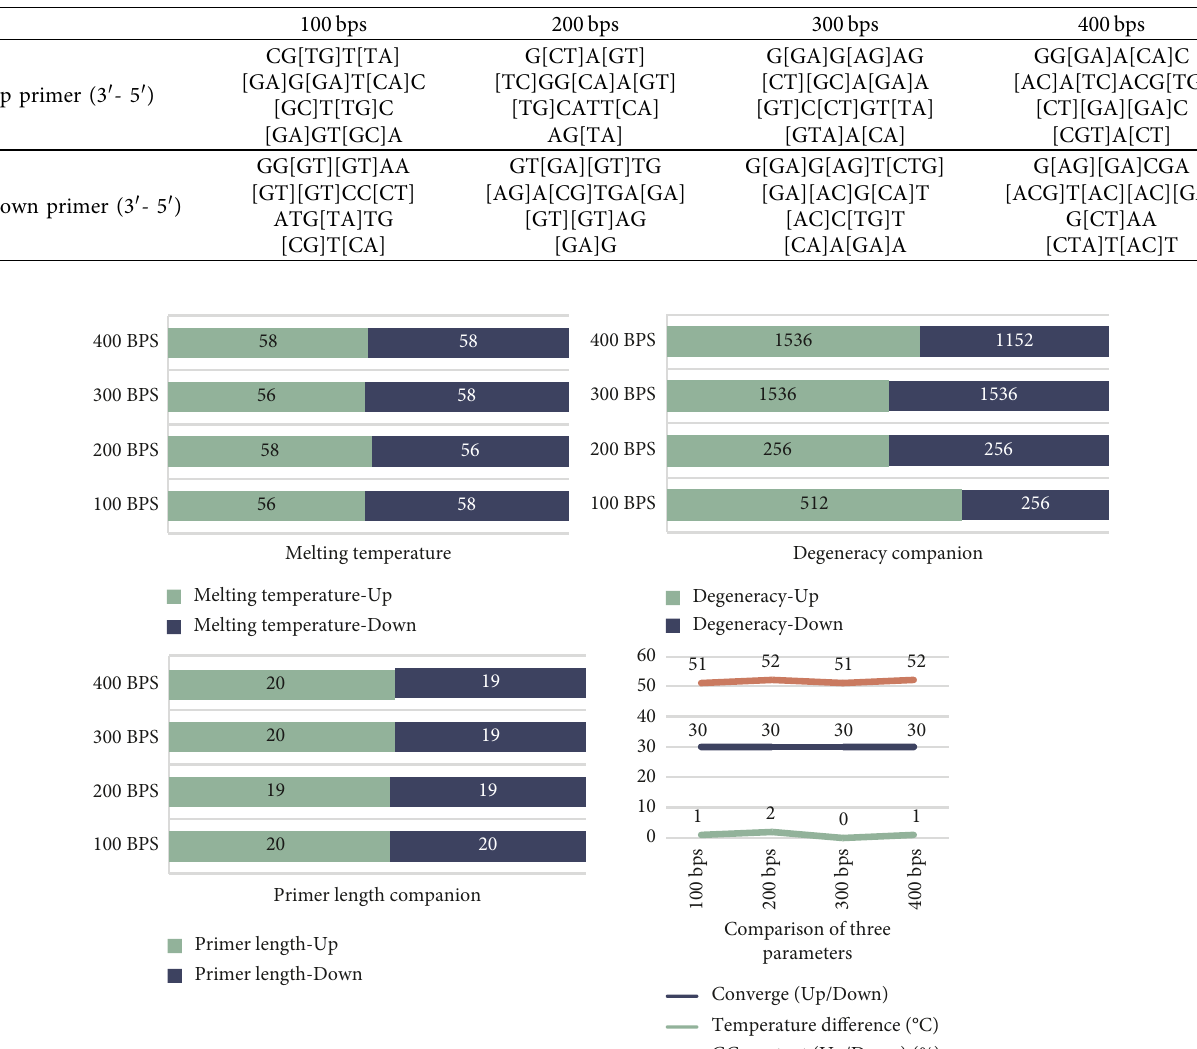
Table 3: An analysis of DNA sequences containing 100bps, 200bps, 300bps, and 400bps.